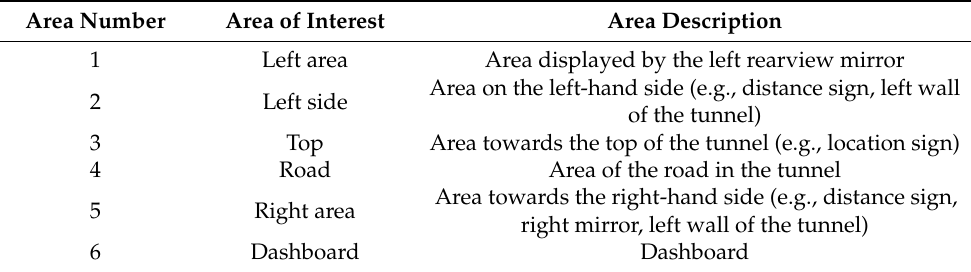
Table 2. Classification of gaze targets in each area.